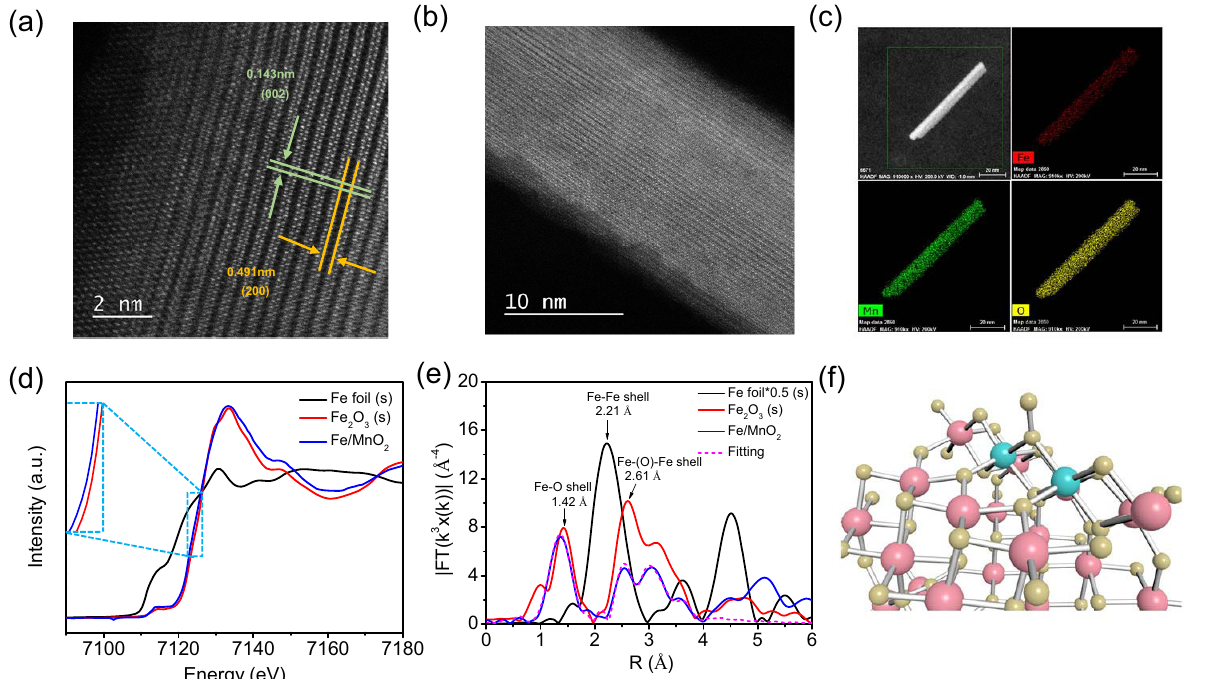
Fig. 1 Structure characterization of Fe/MnO 2 . a and b HAADF-STEM images of Fe/MnO 2 at different magni fi cations. c Element mapping images of Fe/ MnO 2 . d Normalized XANES spectra of Fe. e Fourier-transformed K-edge EXAFS spectra in R-space of Fe (without phase correction) and the fi tting of Fe/ MnO 2 structure in ( f ).